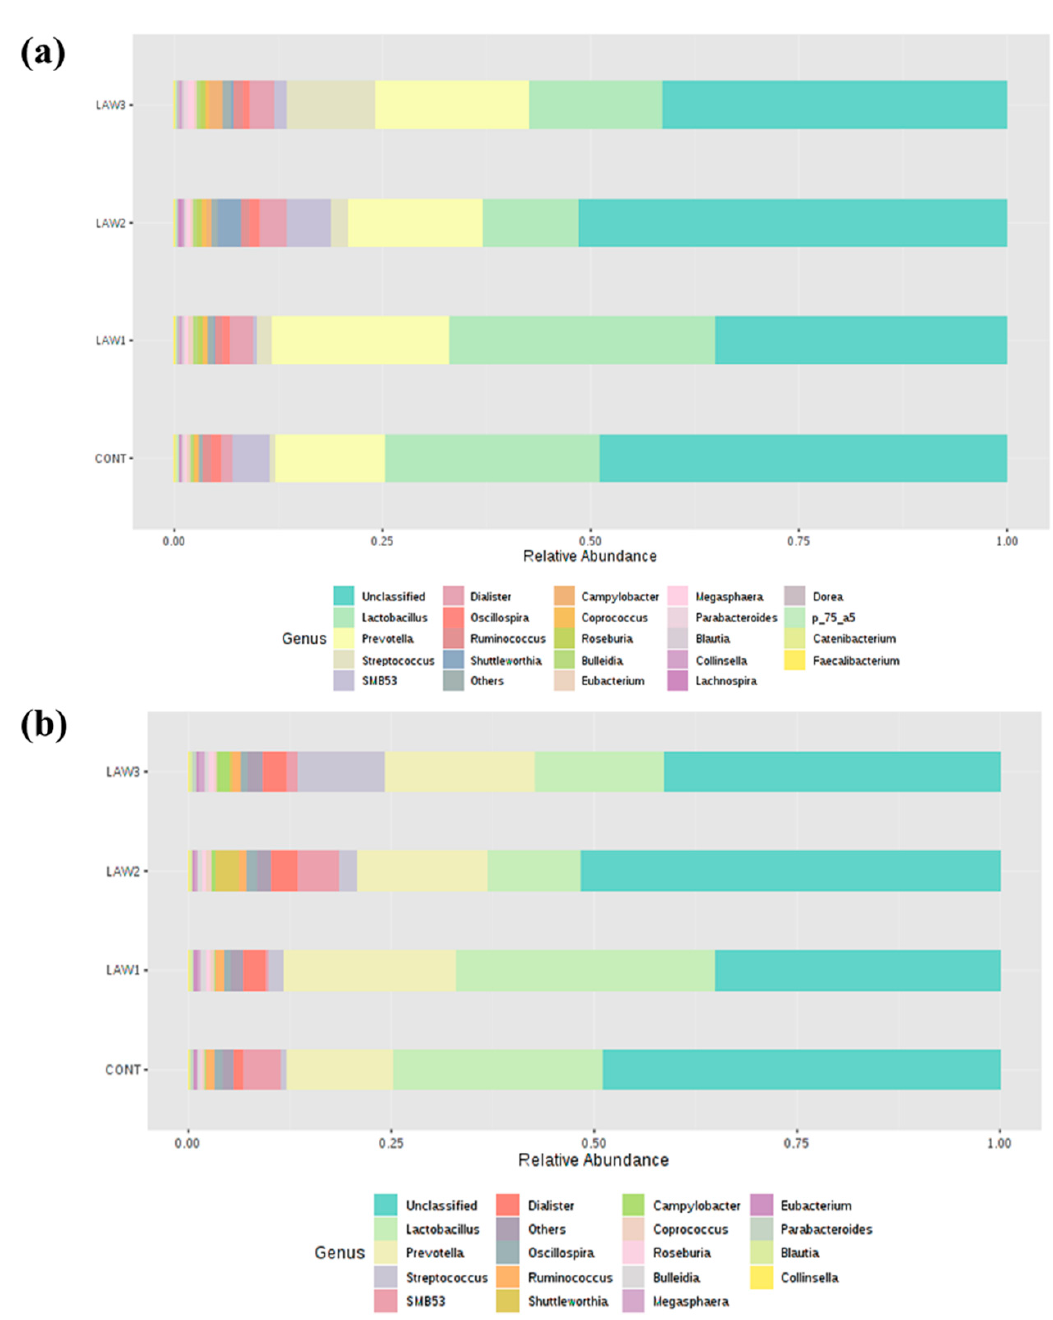
Figure 4. Gut microbiota composition at the genus level in pigs orally vaccinated with Lawsonia intracellularis vaccine. Bar plots show the relative abundance of taxa at the genus level at ( a ) week 0 and at ( b ) week 6 among the four treatment groups (CONT, LAW1, LAW2 and LAW3).